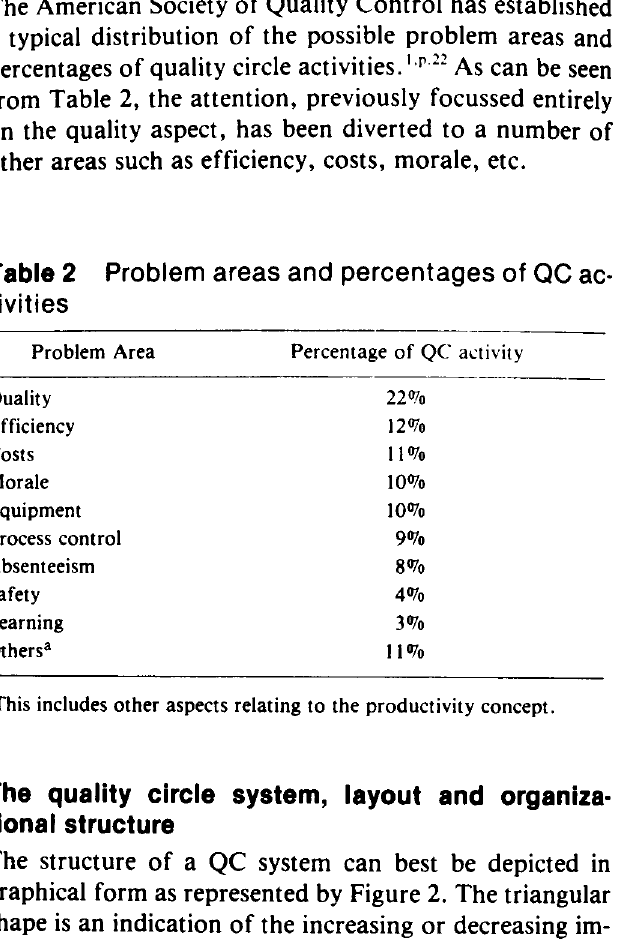
Annual average per capita income in Japan between 1945 and